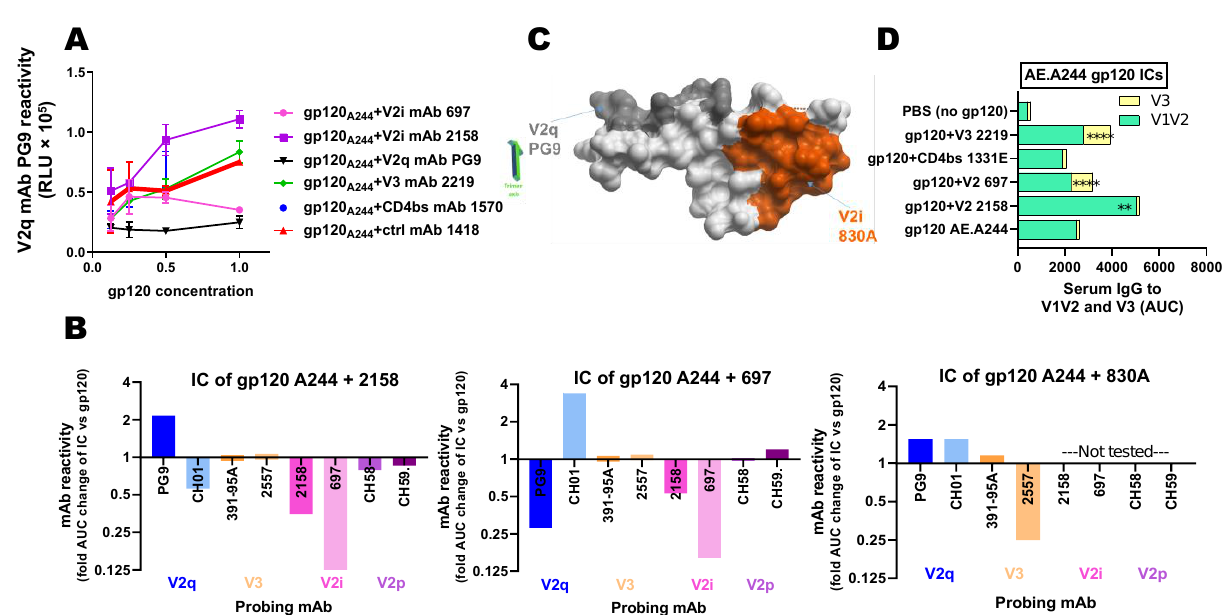
Figure 3. Altered immunogenicity and antigenicity of gp120 A244 upon IC formation. ( A ) Changes in PG9 reactivity of gp120 AE.A244 upon IC formation with distinct mAbs [42]. ( B ) Fold changes in mAb reactivity to gp120 AE.244 in complex with V2i mAbs 2158, 697, and 830A vs. un-complexed gp120 treated with control mAb 1418 as probed by V2q, V3, V2i, and V2p mAbs [42]. ( C ) Location of PG9 epitope at the top of the V1V2 apex near the trimer axis vs. V2i 830A epitope in the underbelly of V1V2 toward its distal end [59,60]. ( D ) Mice were immunized with gp120 AE.A244 alone or in complex with mAb (s.c. 4x) [42]. Sera from 2 weeks after the last injection were diluted and tested in ELISA for reactivity with V1V2 (V1V2 ZM109, Clade C) or V3 (A244, CRF_01.AE). Areas under curves (AUCs) were calculated from titration curves. **, p < 0.001; ****, p < 0.0001 vs. the gp120 group.